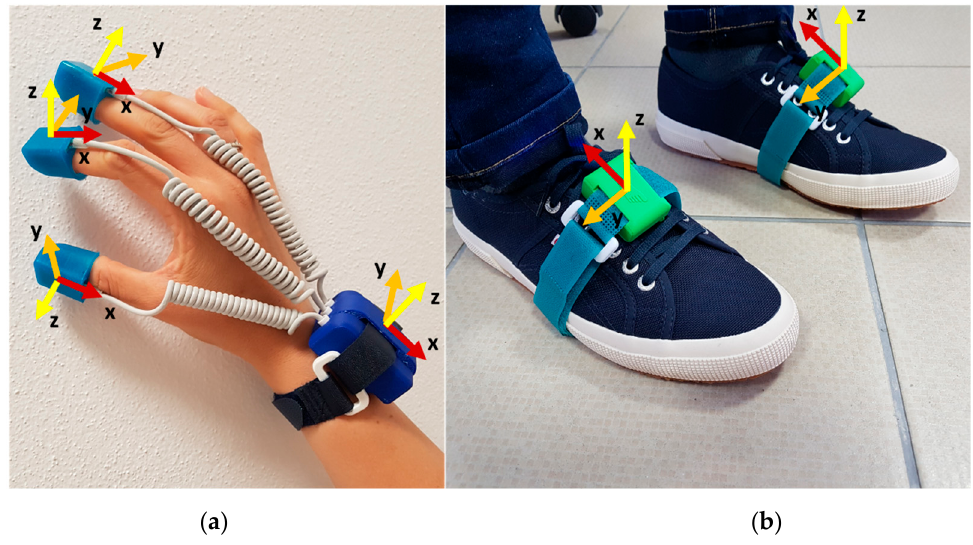
Figure 1. The wearable system: ( a ) SensHand for the right hand; ( b ) the two SensFoot. The axes of inertial sensors are reported for each unit of the system ( x -axis in red, y -axis in orange, z -axis in yellow).